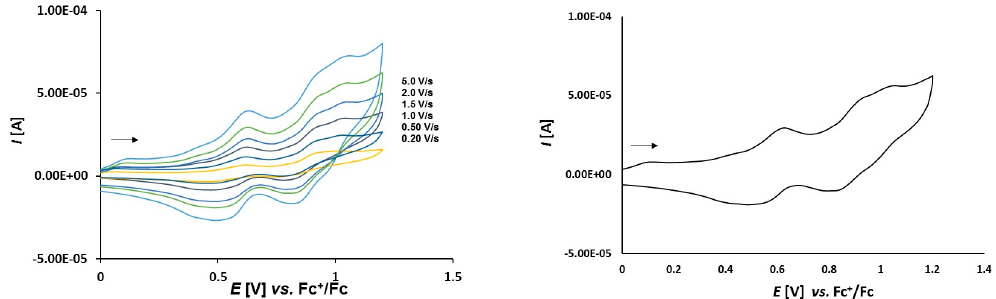
Figure 10. Cyclic voltammetry of complex 3c (1.0 mmol/L) in CH 2 Cl 2 -[ n Bu 4 N][BF 4 ] (0.1 m/L) solutions at various scan rates ( left ) and at v = 2.0 V/s ( right ). The potentials E are given in V and referenced to the Fc + /Fc couple. The arrows indicate the scan direction.